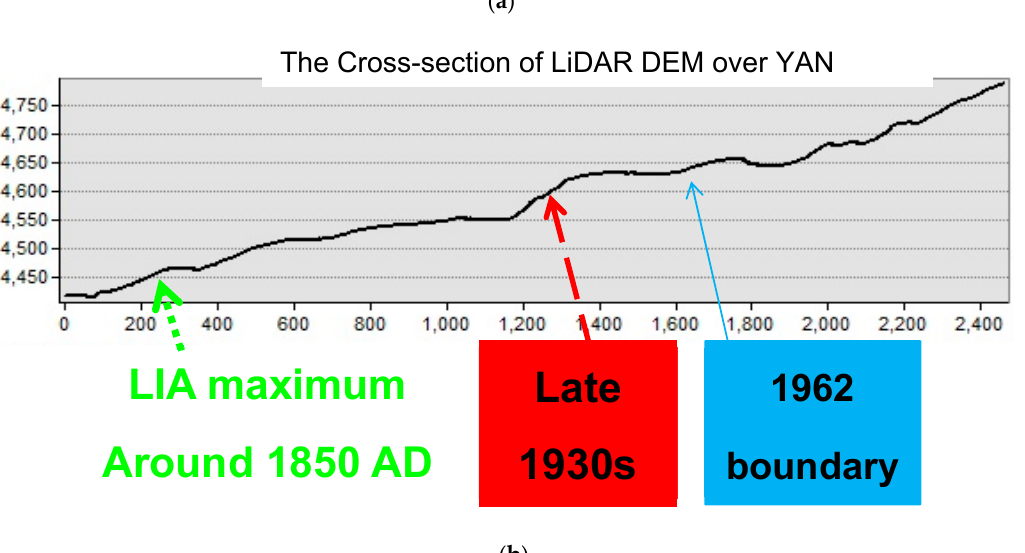
Figure 6. ( a ) The simulation result of the time series of the modeled glacier terminus positions from the Little Ice age (LIA) maximum (1850 AD) up to 1988 AD for YAN. ( b ) The cross-section of LiDAR DEM used to verify LIA moraine positions over YAN.